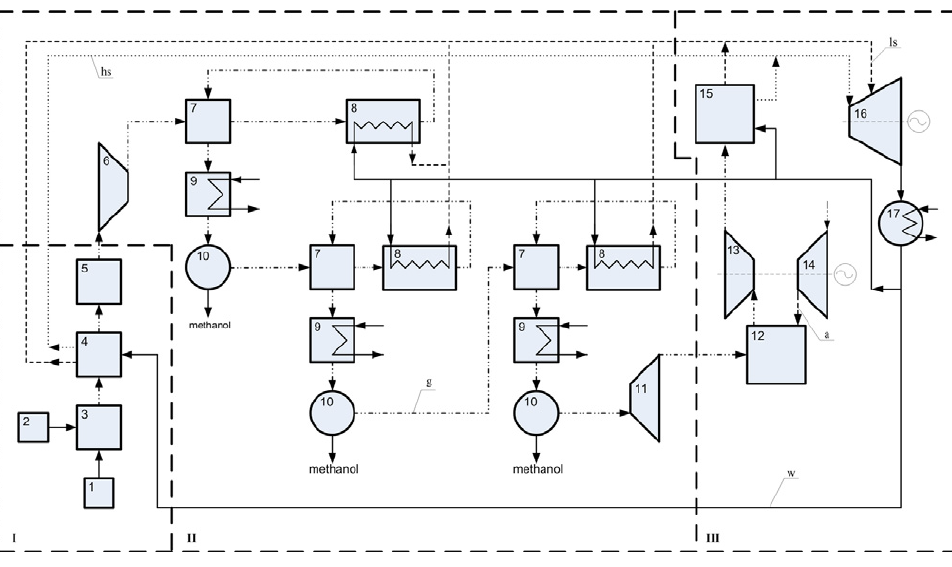
Fig. 1. Flow diagram of